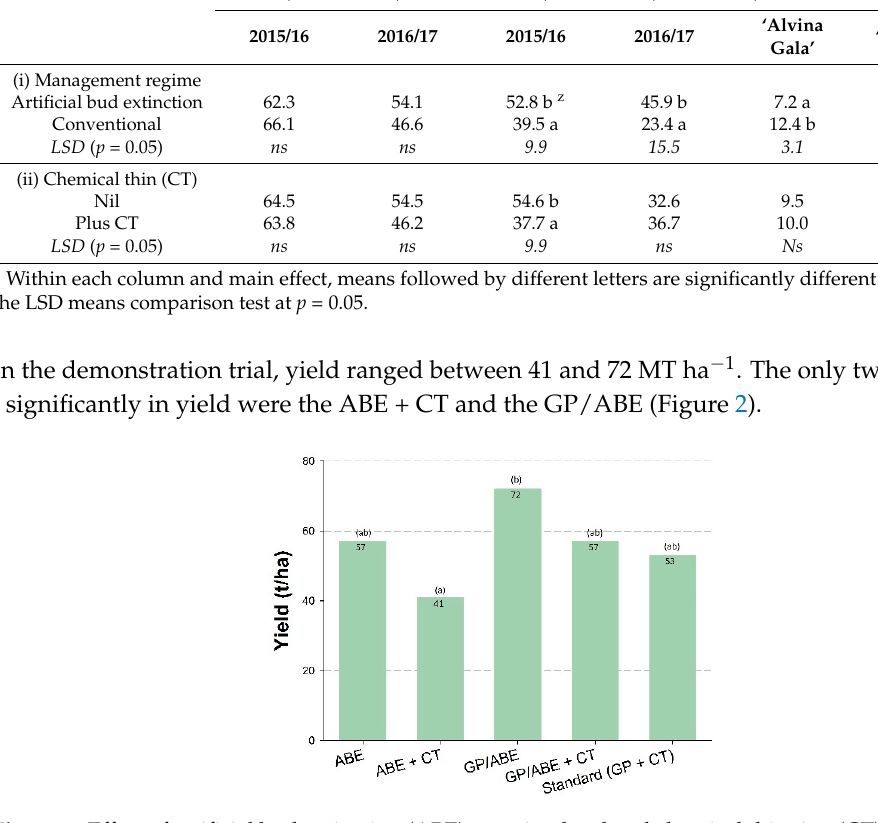
Figure 2. Effect of artificial bud extinction (ABE), pruning level and chemical thinning (CT) on yield of ‘Buckeye Gala’ in Trial 4. Letters above bars indicate mean separation. GP = grower pruned.